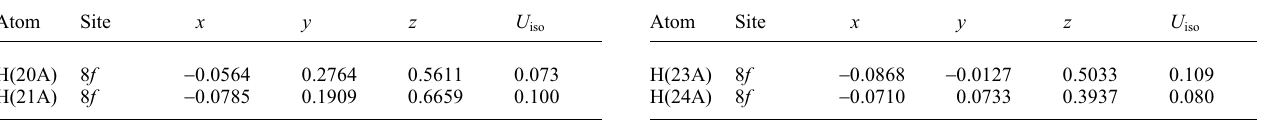
Table 3. Atomic coordinates and displacement parameters (in Å 2 )